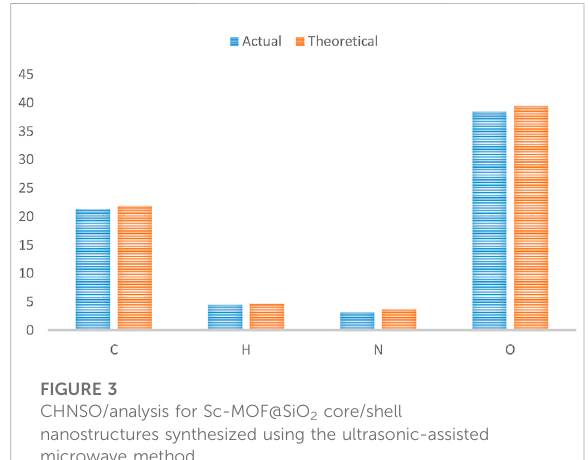
FIGURE 2 FTIR spectra of (A) SiO 2 , (B) Sc-MOF, and (C) Sc-MOF@SiO 2 core/shell nanostructures.